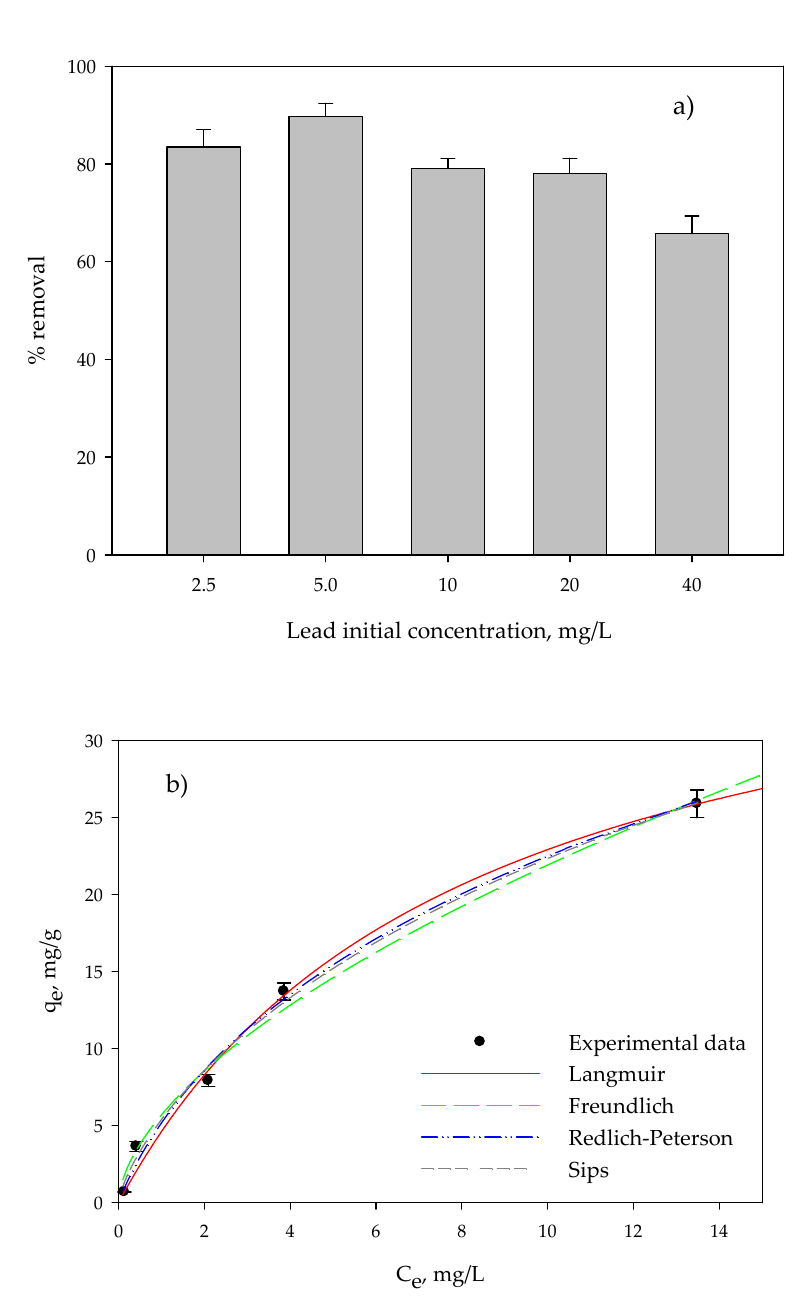
Figure 3. ( a ) Removal percentages of lead at different initial lead concentrations; ( b ) Adsorption isotherms of lead. Experimental data and fit to the different models.